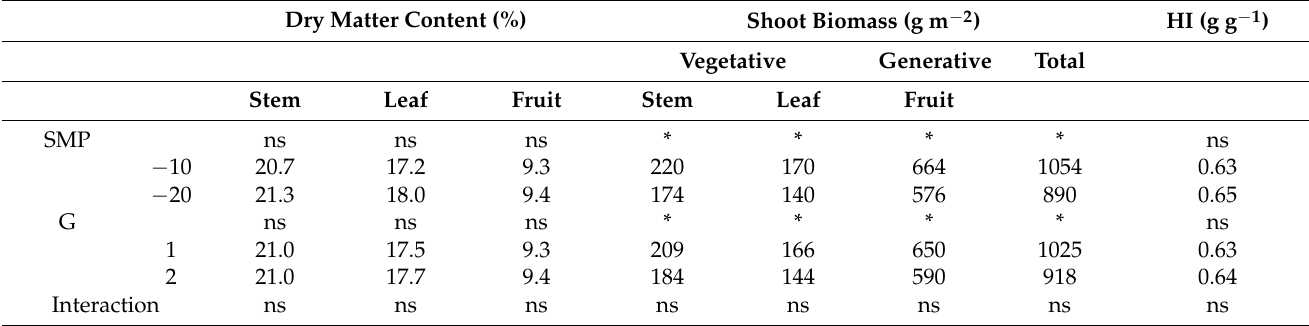
Table 5. Stem, leaf and fruit dry matter. Vegetative, generative and total shoot biomass, and crop harvest index (HI). Dry Matter Content (%)